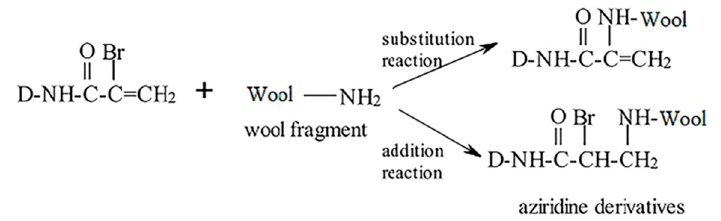
Figure 7. Dying mechanism of Lanasol CE dye and wool